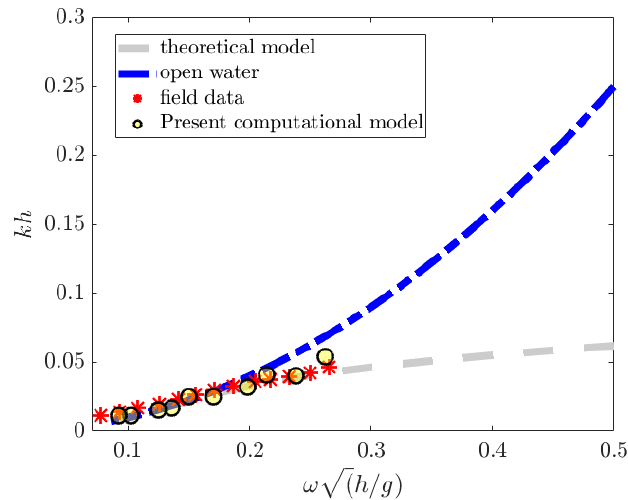
Figure 17. Dispersion curves of waves propagating in the covered (markers and dashed curve) and uncovered sea (dash-dotted blue curve). Field data (* markers) are taken from [33]. The dashed curves show the dispersion curve constructed using Equation (5). The results of the present model (circle markers) are found by running the model for small-scale ice.